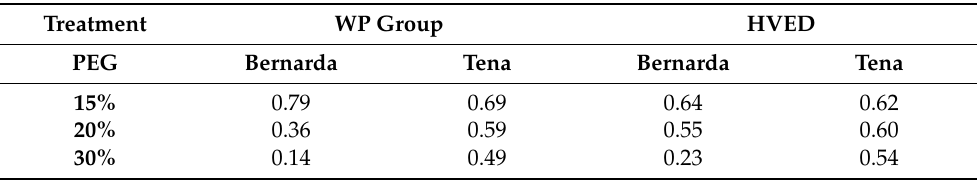
Table 3. Germination index of drought resistance (GIDR) in WP group of plants (without pre- treatment) and high voltage electrical discharge (HVED) pre-treated group under control and different PEG